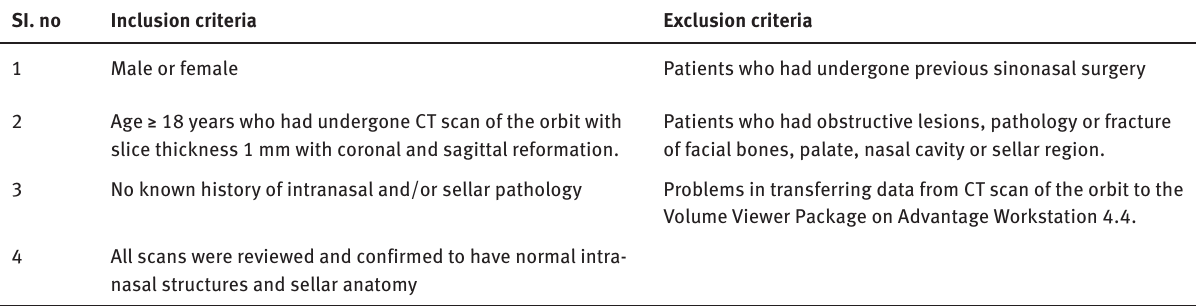
Table 1: Inclusion and exclusion